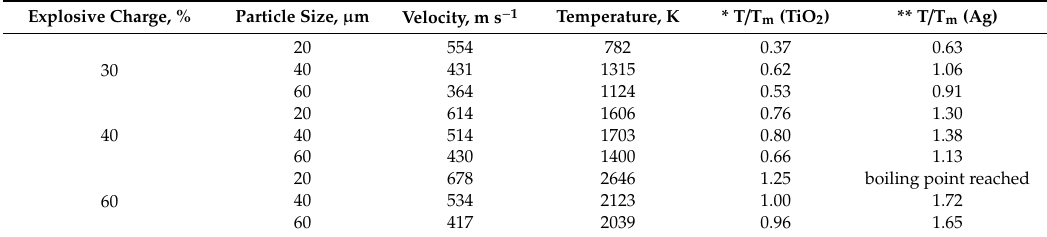
Table 2. Calculated temperatures and velocities of composite TiO 2 -2.5 vol. % Ag particles 20, 40